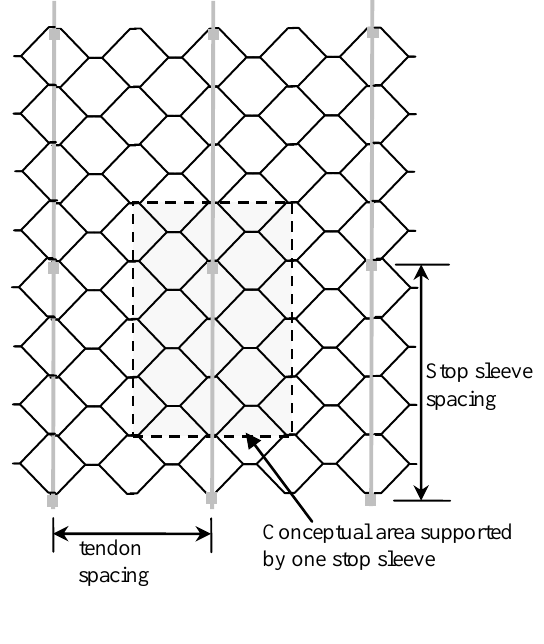
Figure 6. Key tendon design parameters for geocell reinforcement.